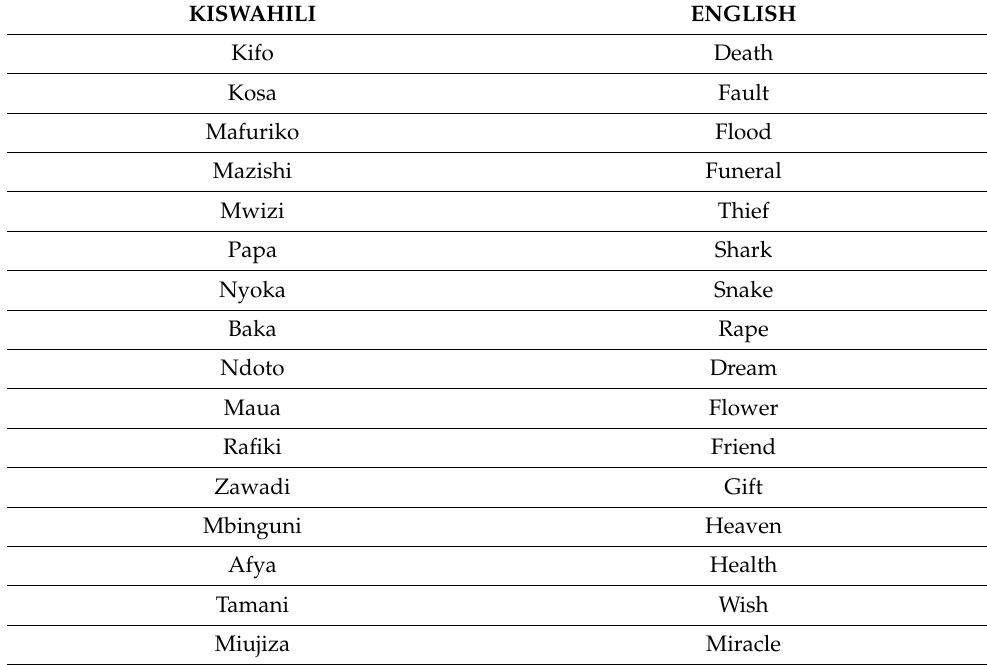
Table A2. Emotion-laden words used in